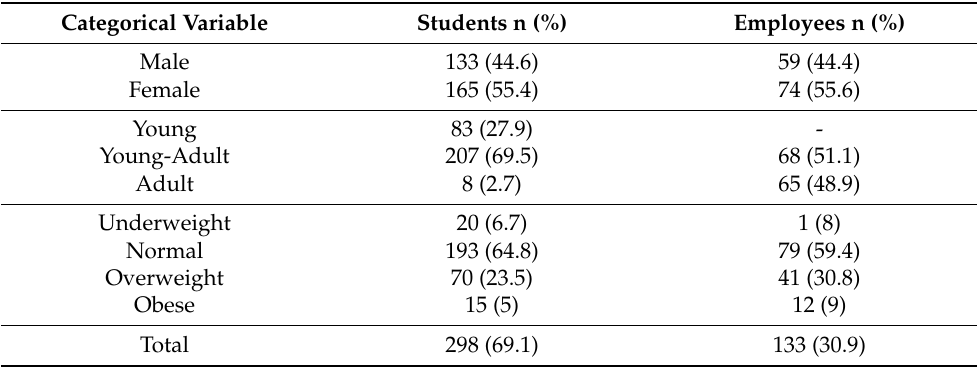
Table 1. Characteristics of the participants (n =